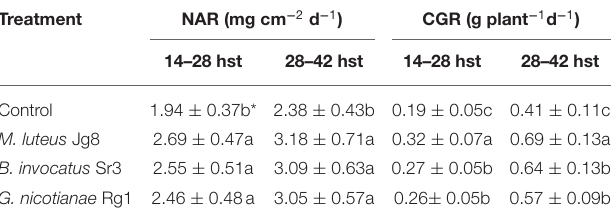
TABLE 8 | Effect of rhizobacteria to the net assimilation rate (NAR) and crop growth rate (CGR) at 14–28 and 28–42 DAP of corn cultivar Pertiwi.